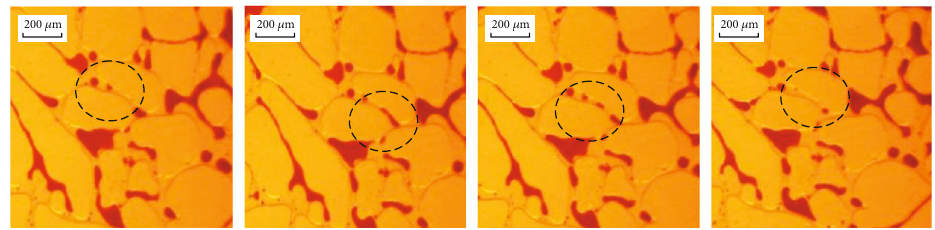
Figure 13: Schematic diagram of the displacement process of oil drop residual oil (oil in pores is indicated by the red color).